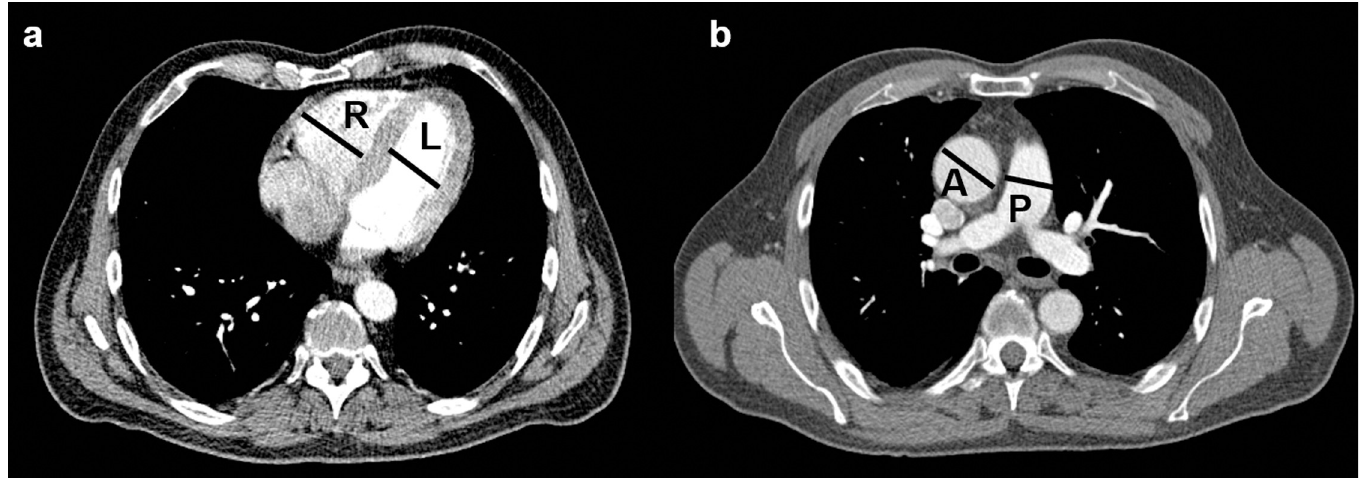
Fig 1. CT measurements. a) Right/left ventricular ratio was calculated by dividing the maximal distance between the ventricular endocardium and the interventricular septum, perpendicular to the long axis of the heart measured on standard axial views. The maximum dimensions for both ventricles where used for measurements. b) The pulmonary artery and ascending aorta were assessed on a transverse image at the level of the pulmonary artery bifurcation. Vessel diameters were obtained by measuring the widest diameter vertical to the long axis of the main pulmonary artery.